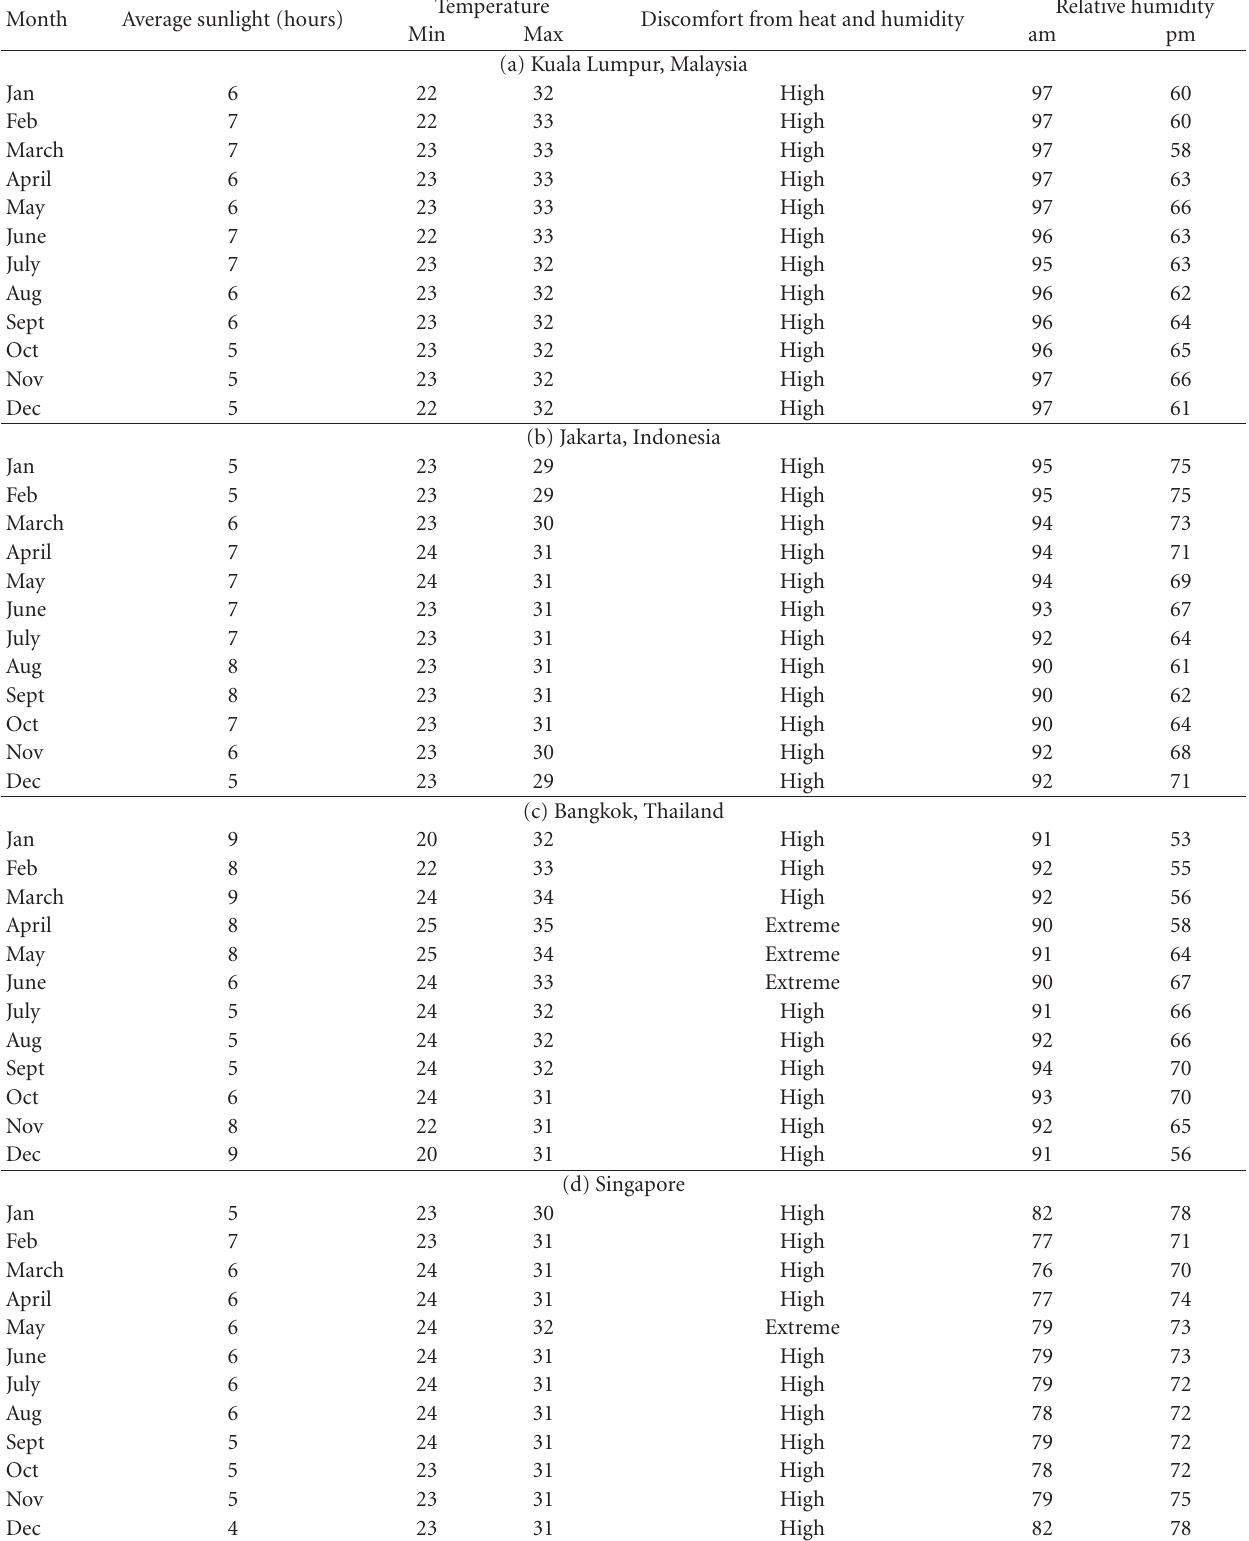
Table 2: A summary of the meteorological data of 2005 in average weather conditions ∗